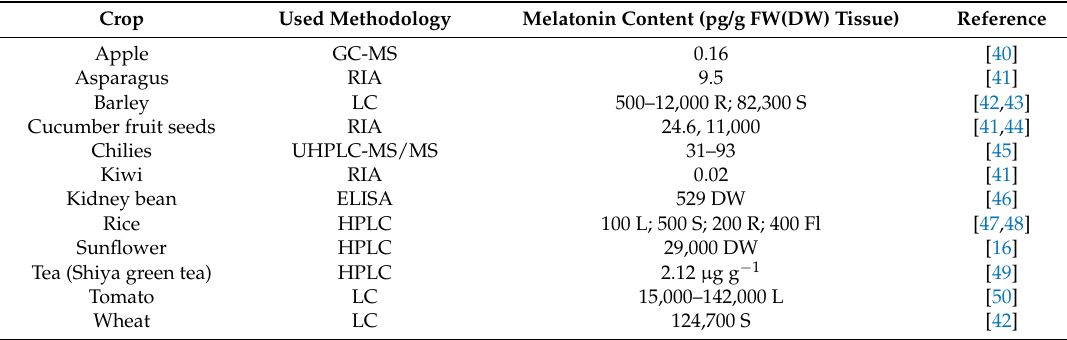
Table 1. Reported concentration of melatonin in some edible